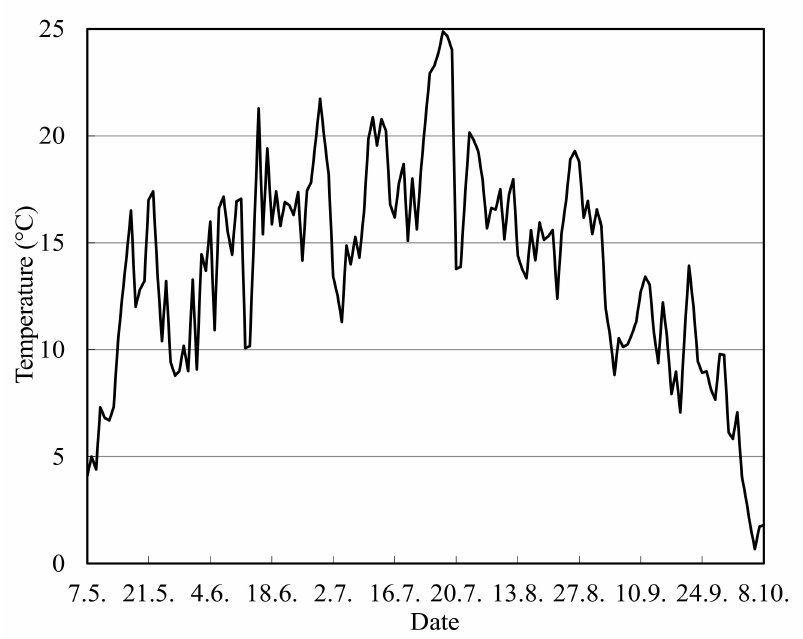
Figure 1. Daily mean temperatures at the experimental site at NIBIO Apelsvoll during the summer months of